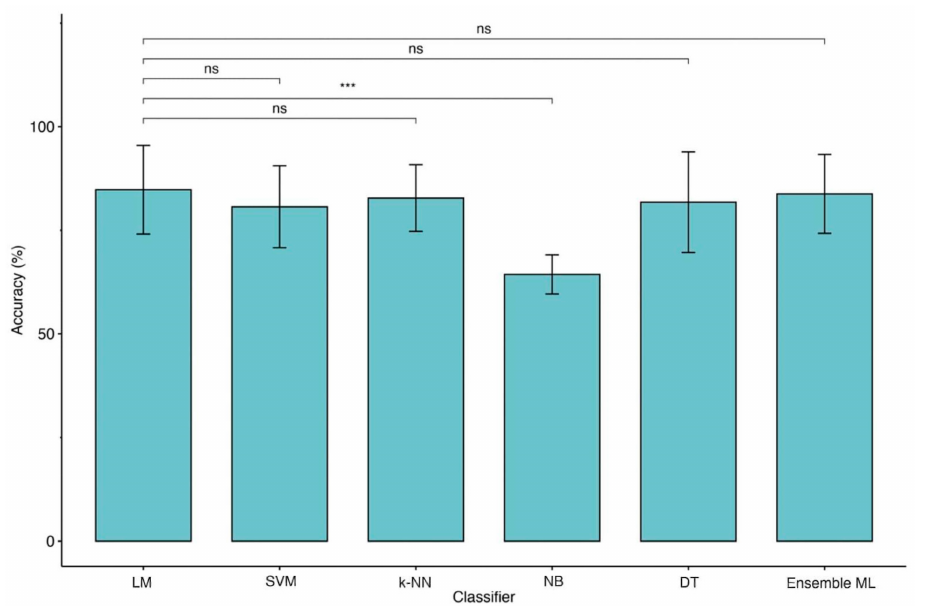
Figure 4. Comparison of accuracies between LM and ML models (2 classes of outcome). Legend: Linear Regression Model (LM), Support Vector Machine (SVM), k-Nearest Neighbors (k-NN), Naïve Bayes (NB), Decision Tree (DT) and Ensemble of Machine Learning models (Ensemble ML). Symbols ***, p -values <0.001.